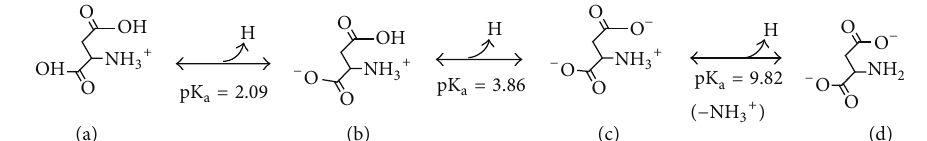
Figure 8: Coordination behaviour of aspartic acid: a function of the pH of the reaction. (a) In strong acid (below pH 1); net charge = +1. (b) Around pH 3; net charge = 0. (c) Around pH 6–8; net charge = − 1. (d) In strong alkali (above pH 11) net charge = −